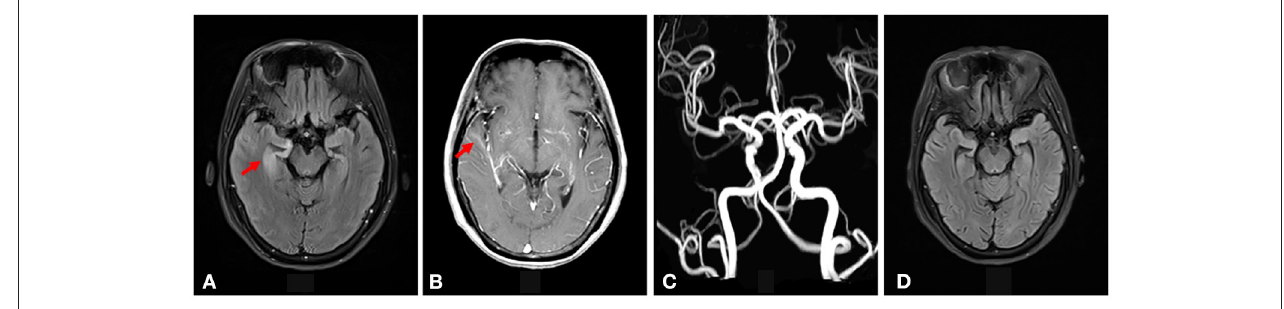
FIGURE 2 | (A) Increased signal intensity was seen on the T2-weighted FLAIR imaging in the right medial temporal lobe (shown by the red arrow). (B) Gadolinium-enhanced MRI of the brain showed mild to moderate cord enhancement in the right temporal lobe (shown by the red arrow). (C) The brain MRA did not show vascular stenosis or vasculitis-like changes. (D) The increased signal intensity on T2-weighted FLAIR imaging in the right medial temporal lobe disappeared after syphilitic